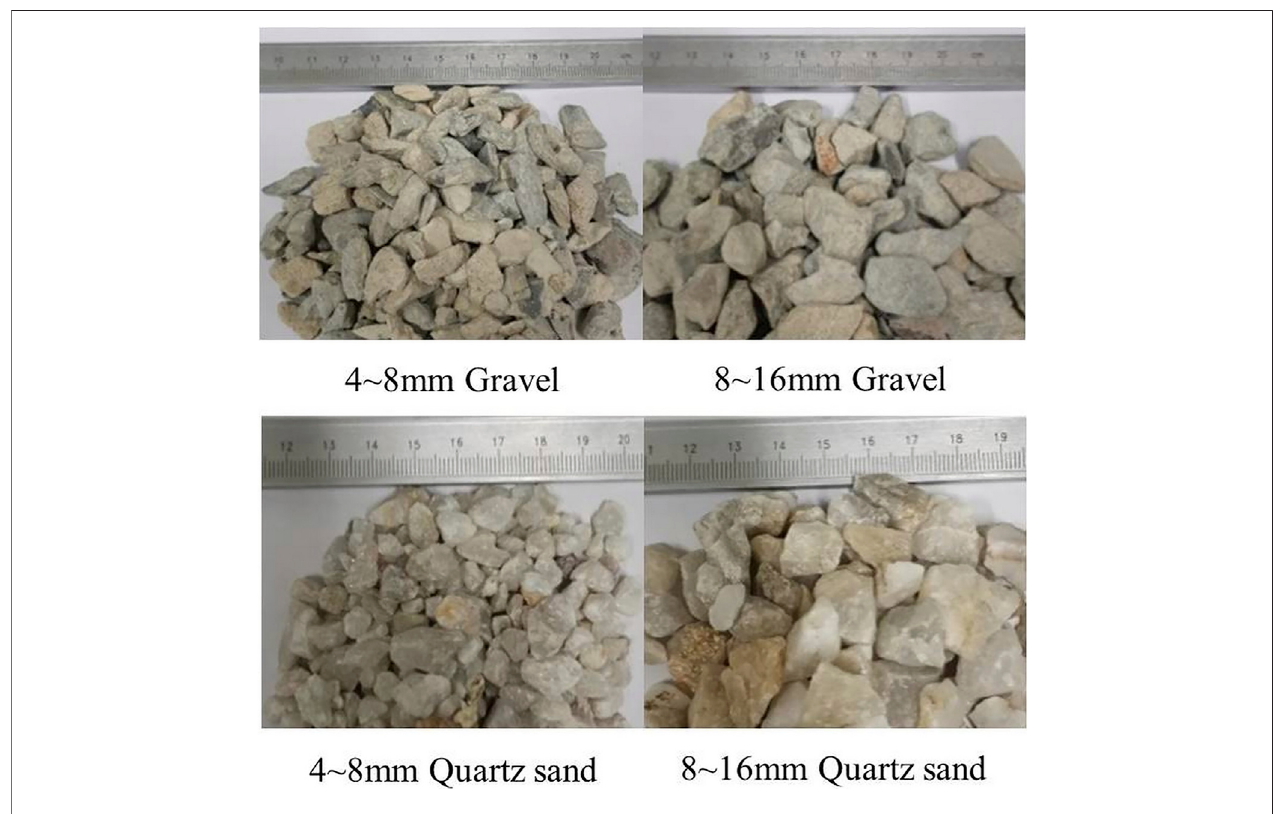
FIGURE 4 | Photographs of the back fi ll materials.